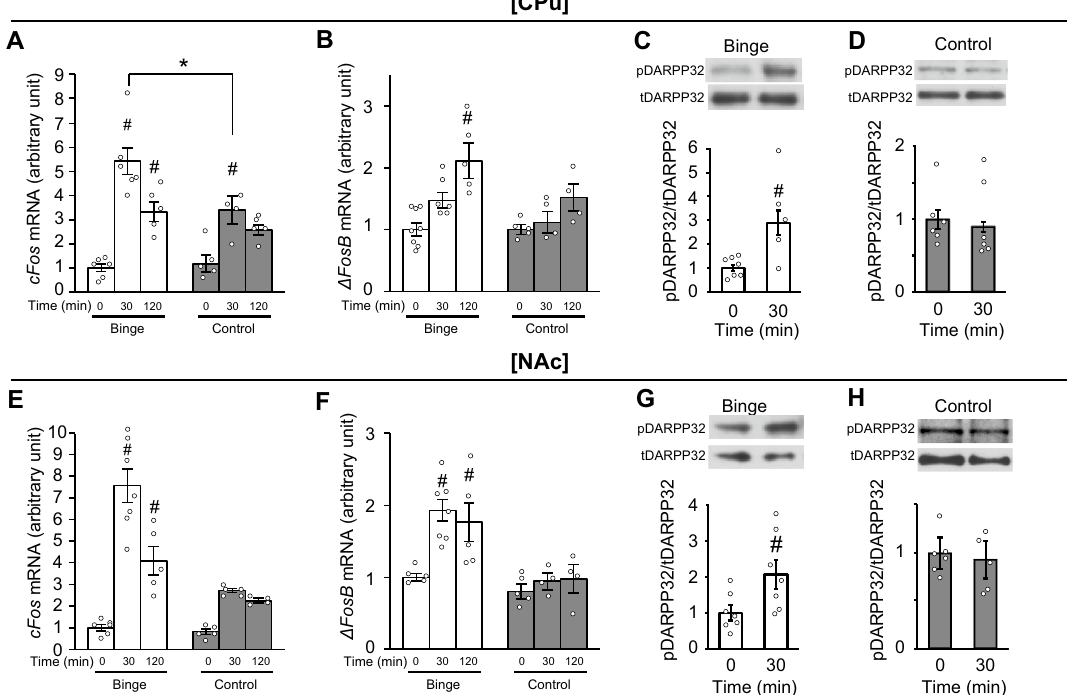
Figure 1. Intermittent access to a HFD induces binge-like eating with neural activation in the striatum. ( A and B ) The mRNA expression levels of cFos ( A ) and ΔFosB ( B ) in the caudate putamen (CPu) in binge and control mice groups. ( C and D ) The phosphorylation of dopamine- and cyclic-AMP–regulated phosphoprotein of molecular weight 32,000 (DARPP32) in the CPu in binge ( C ) and control ( D ) groups. ( E and F ) The mRNA expression levels of cFos ( E ) and ΔFosB ( F ) in the nucleus accumbens (NAc) in binge and control groups. ( G and H ) The phosphorylation of DARPP32 in the NAc in binge ( G ) and control ( H ) groups. All values are mean ± SEM. Statistical analyses were performed using two-way factorial analysis of variance (ANOVA) ( A , B , E , and F ) followed by Sidak’s post-hoc test or an unpaired t -test ( C , D , G , and H ). # p < 0.05 versus 0 min in the same group. * p < 0.05 versus control. See also Supplemental Table 2 for details on